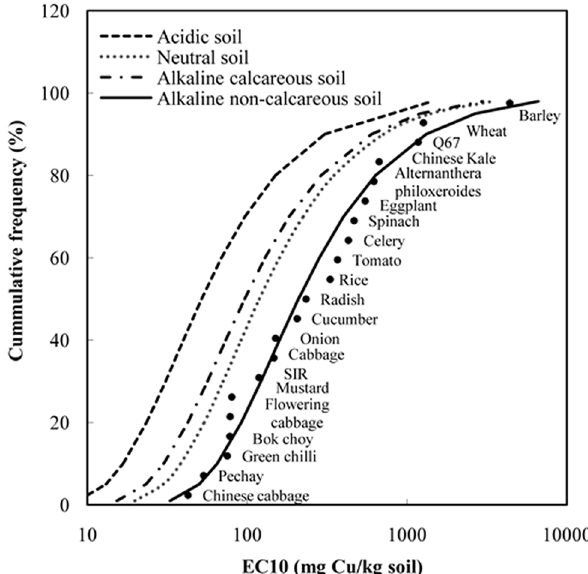
Fig 4. The Cu SSD curves fitted by Burr III functions for four representative scenarios of Chinese soils. The dots in the figure are Cu EC10 ecotoxicity data normalized to alkaline non-calcareous soil condition. SIR is substrate-induced respiration assay. Q67 is a toxicity test using bioluminescent bacteria Vibrio qinghaiensis . (Table 2). Chinese cabbage was the most sensitive species in the four scenarios, and vegetables had greater sensitivity than grain crops and Q67, as also mentioned by Li et al. [14]. It is ratio- nal to construct SSD curves based on ecotoxicity data on individual plant, micro-organisms and soil animals separately. But the available data on microbial species/processes and soil ani- mals are few and do not comply with the minimum quantity of the SSD method. Actually, the SSD approach is a statistical extrapolation method and the HCx values derived from the SSD curves depend on ecotoxicity data of the number of species and their sensitivity to certain con- taminant toxicity. SIR is a microbial process which is not sensitive to Cu ecotoxicity and has no significant effect on the value of HCx when we used ecotoxicity data of Q67 and SIR together with data on terrestrial species to construct the SSD curves. The HC5 values varied about four- fold among the different soils, i.e. between 13.1 mg/kg (acidic soils) and 51.9 mg/kg (alkaline non-calcareous soils).